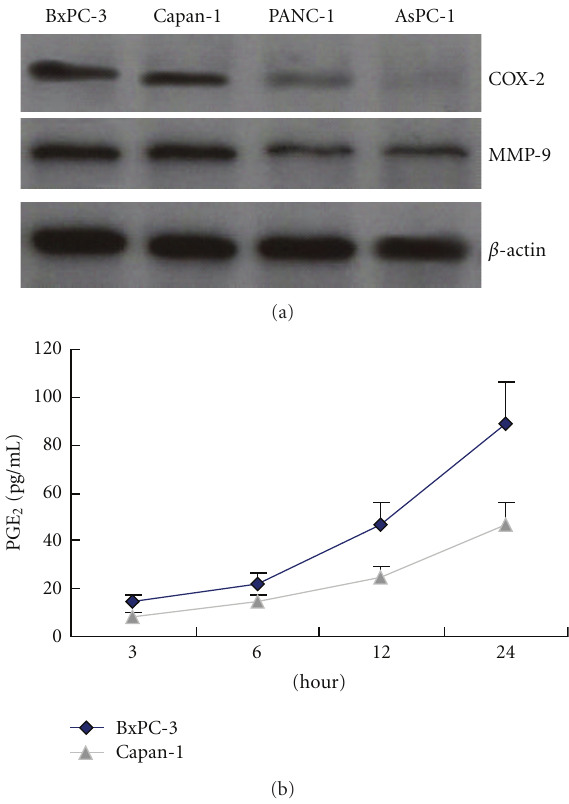
Figure 2: Expression of COX-2 and MMP-9 in pancreatic cancer cell lines. (a) Expression of COX-2 and MMP-9 was detected in pancreatic cell lines BxPC-3, Capan-1, PANC-1, and AsPC-1 by Western blotting. (b) PGE 2 protein in the culture supernatant of BxPC-3 and Capan-1 cells was measured by Elisa. Data are expressed as mean ± SD, n =